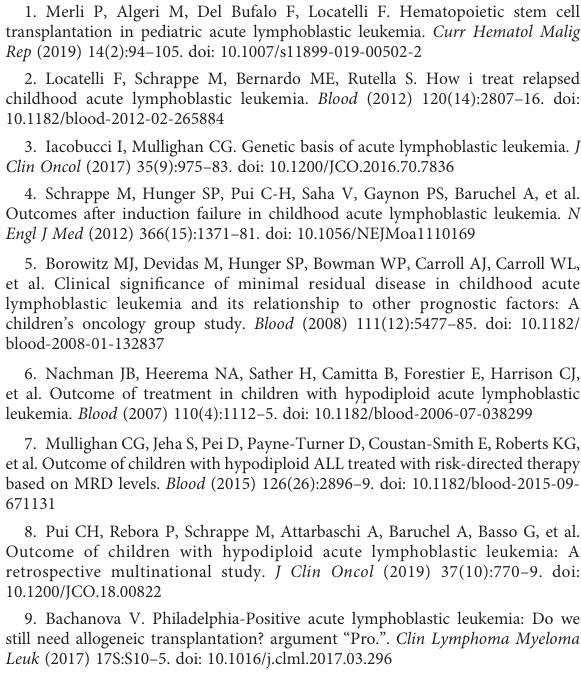
SUPPLEMENTARY FIGURE 1 Cumulative incidence of relapse (CIR) for transplanted patients in CR2 in relation to (A) initial time of pretransplant relapse and (B) initial site of pretransplant